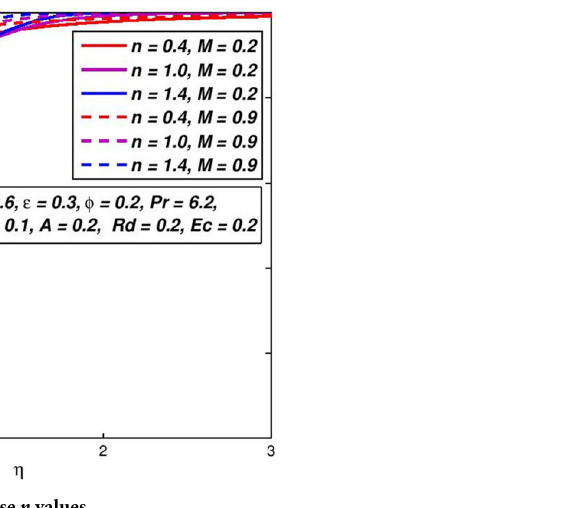
Fig 8. Effect of M on f 0 ( η ) for diverse n